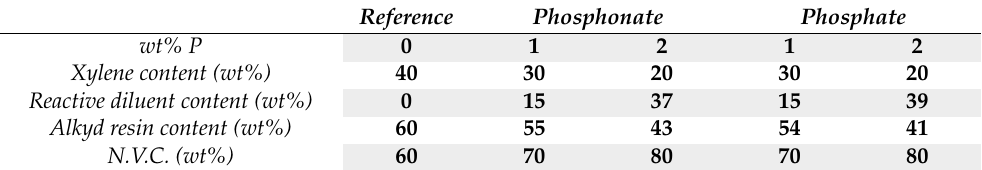
Table 1. Compositions of alkyd resins with PO x CR at the same viscosity (5.6 Pa · s).